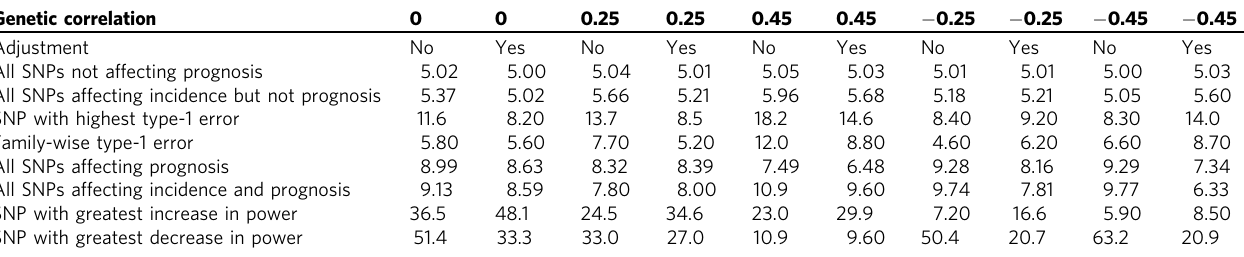
Table 3 Power for binary incidence and prognosis with non-genetic confounding Genetic correlation